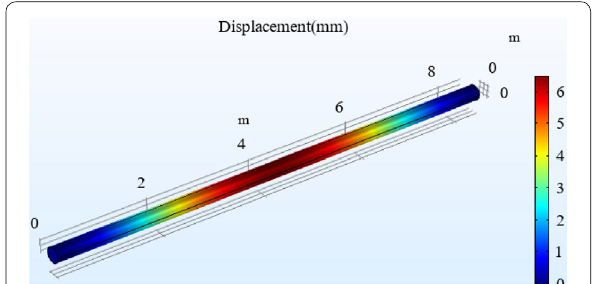
Fig. 6 Displacement of the steel bar after 24 h stope filling.